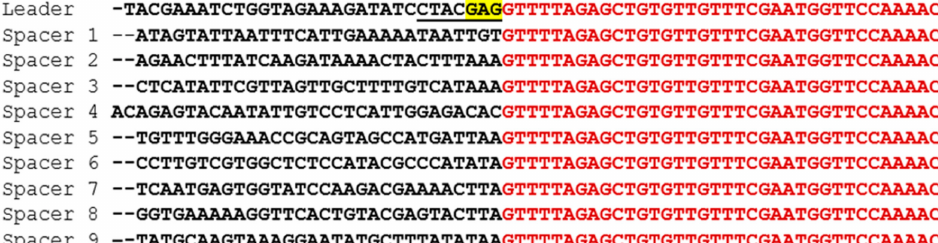
Figure 5. Nucleotide alignment of the leader sequence and spacers of S. thermophilus Uy01. The nucleotide sequence of the repeat is in red and the leader and spacers are in black. The underlined portion of the sequence is the putative LAS sequence of the S. thermophilus CRISPR3 array with the GAG motif highlighted in